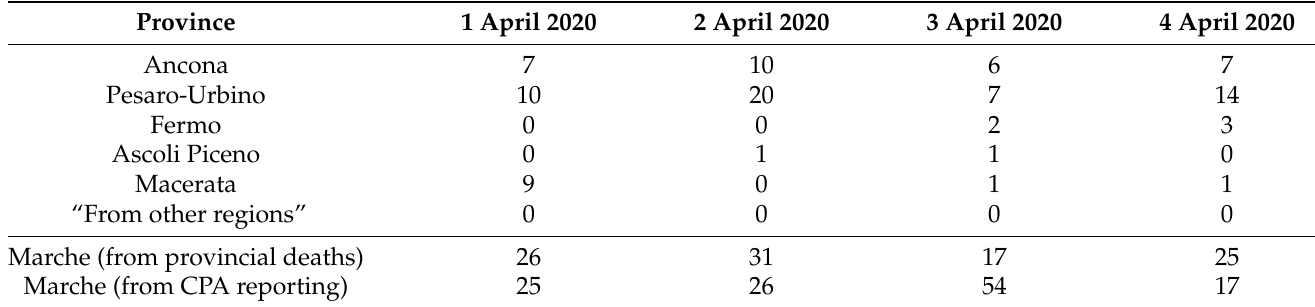
Table 2. Differences between CPA death counts and regional bulletins and local newspapers death counts—Marche region,